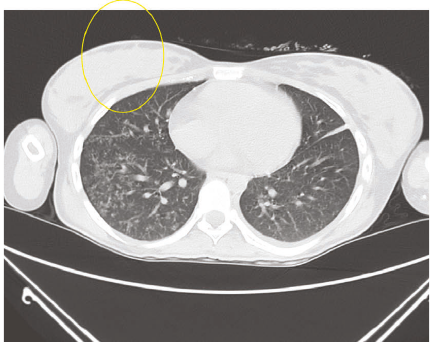
Figure 2: CT chest image demonstrates multiple tree-in-bud opacities within the right lower lobe (yellow circle). Findings can also be seen in the setting of aspiration or other atypical/fungal infections, sarcoidosis, and some viruses such as CMV, among other etiologies.